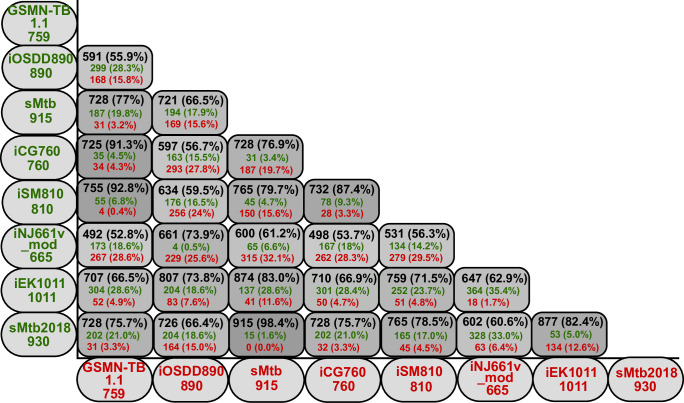
Pairwise matrix of shared genes among Mtb models.Values in black (genes in common between the models), green and red text represent the number and percentage of Mtb model genes specified in the y- and x-axis, respectively.